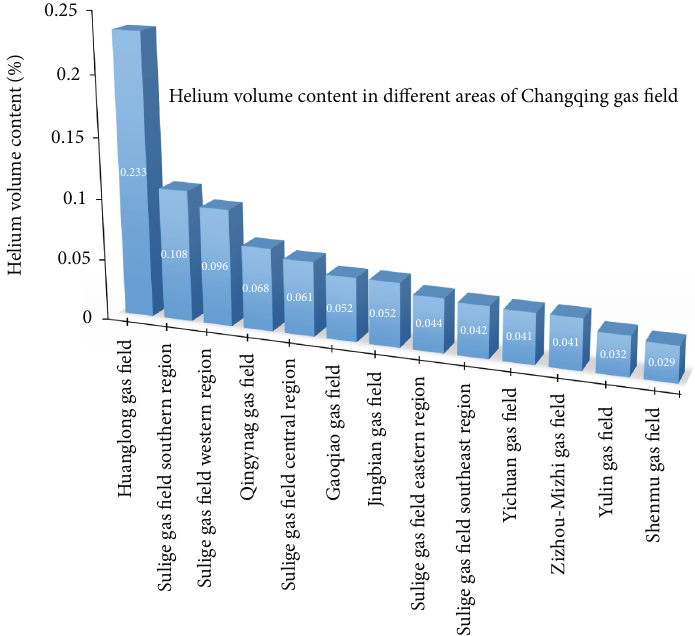
Figure 7: Helium volume content in di ff erent areas of Changqing Gas Field. Table 2: Method of helium extraction from natural gases